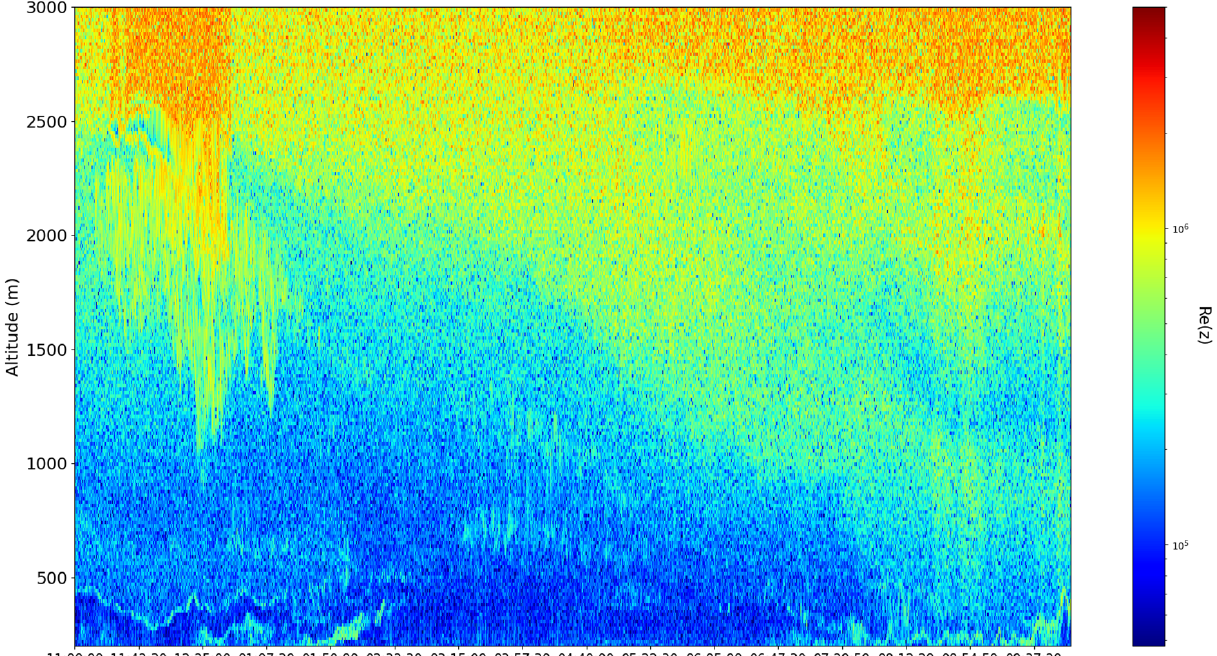
i, Romania, 22 December 2021. ,